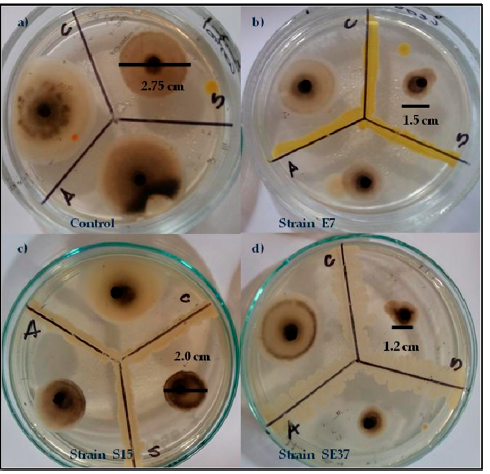
Figure 3. Antagonism effect of three endophytes of the seeds ( b ) E7, ( c ) S15 and ( d ) SE37; against three fungal pathogens of tomato in vitro: Alternaria alternata , C orynespora cassicola and S temphylium lycopersici . ( a ) Plate control without inoculation. Bars indicate the diameter of the fungal colonies (cm).